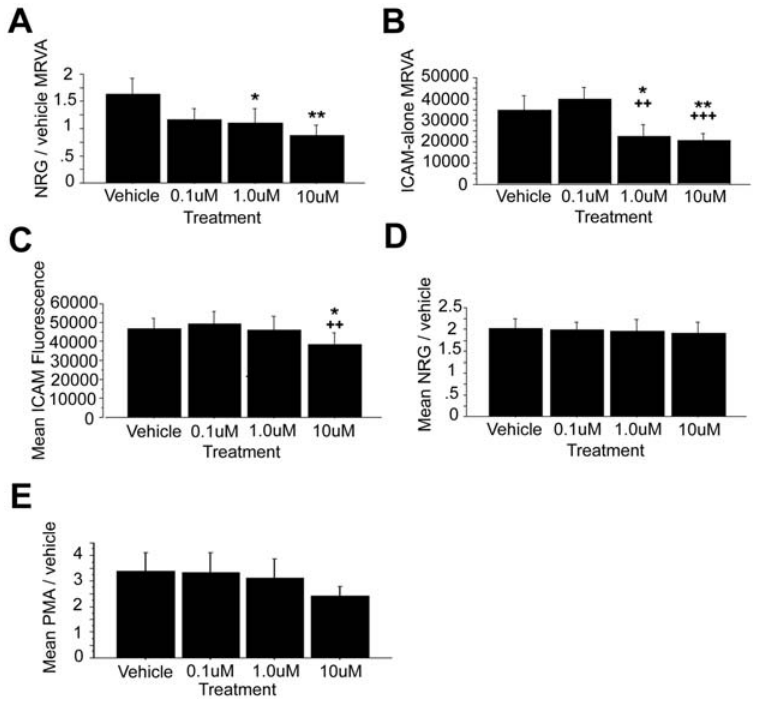
Figure 6. Phospholipase C (PLC) is essential for maintaining an adhesive state in general. While the PLC inhibitor U73122 in ethanol vehicle (n=5) did cause a significant reduction in NRG/vehicle MRVA (A) and a trend towards reduction in PMA/vehicle MRVA (not shown), it exerted a much stronger effect on dampening baseline MRVA due to the presence of ICAM and endogeneous signaling alone (B) . Furthermore, at high dose, it caused a significant reduction in baseline ICAM attachment (C) and in mean NRG and PMA attachment (raw fluorescence values) (not shown). However, mean NRG/vehicle (D) and mean PMA/vehicle (E) were not significantly changed. Compared with the vehicle control, * represents p , 0.05 and ** represents p , 0.01. Compared with the low dose, ++ represents p , 0.01 and +++ represents p ,